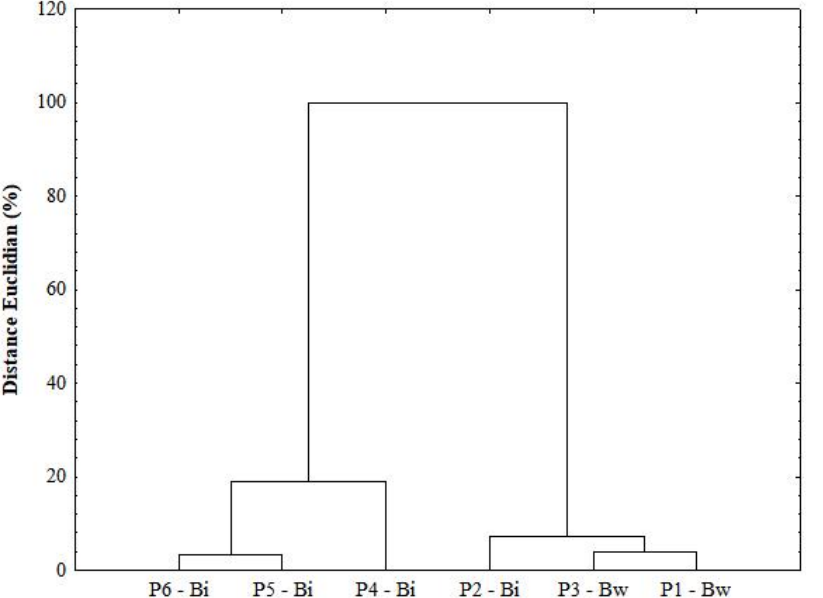
Figure 4. Vertical dendrogram of the distance matrix by the single bond grouping method. P1: Red- yellow Ferralsol—Bw; P2: Haplic Cambisol—Bi; P3: Yellow Ferralsol—Bw; P4: Haplic Cambisol—Bi;